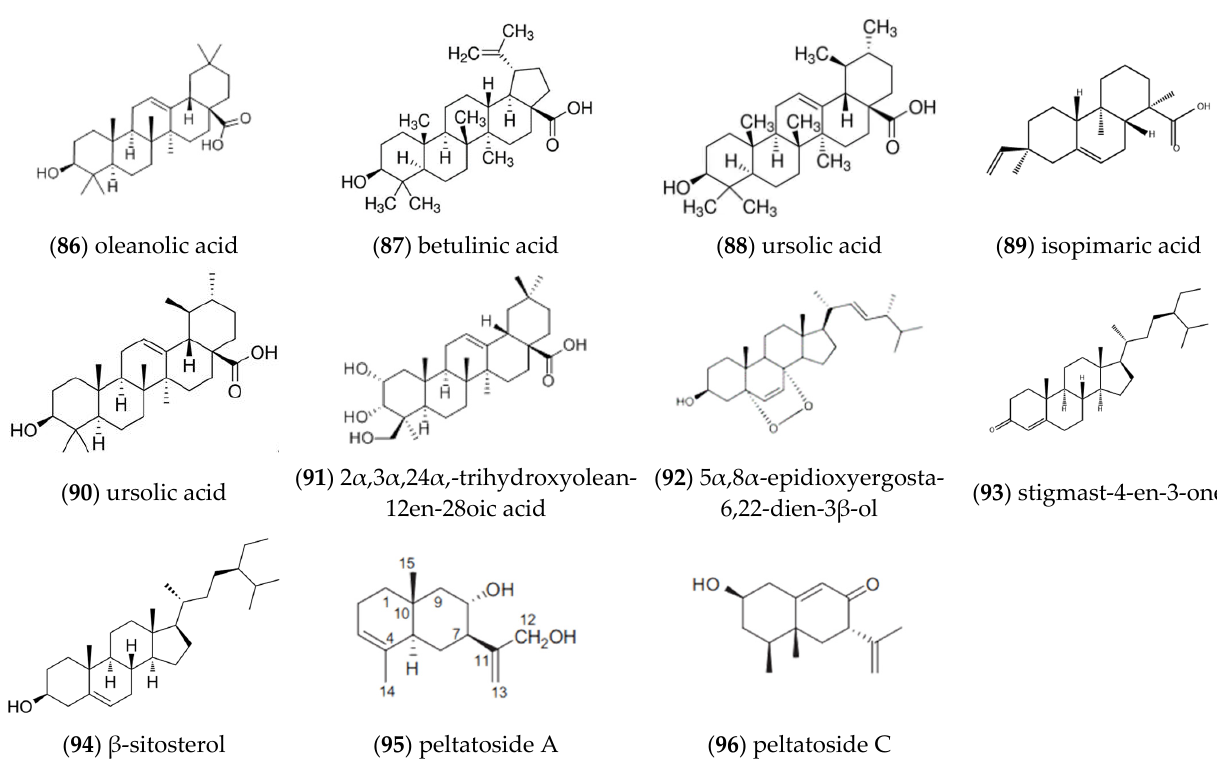
Figure 8. Structures of other terpenoids isolated from ST .